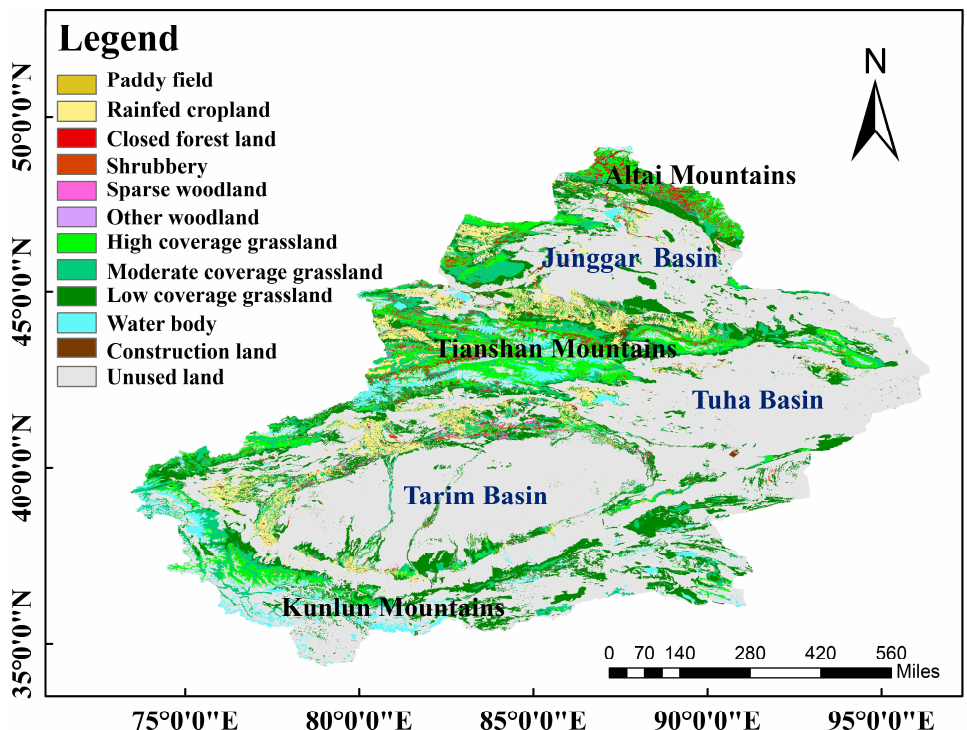
Figure 4. Land use map in Xinjiang (secondary classification).